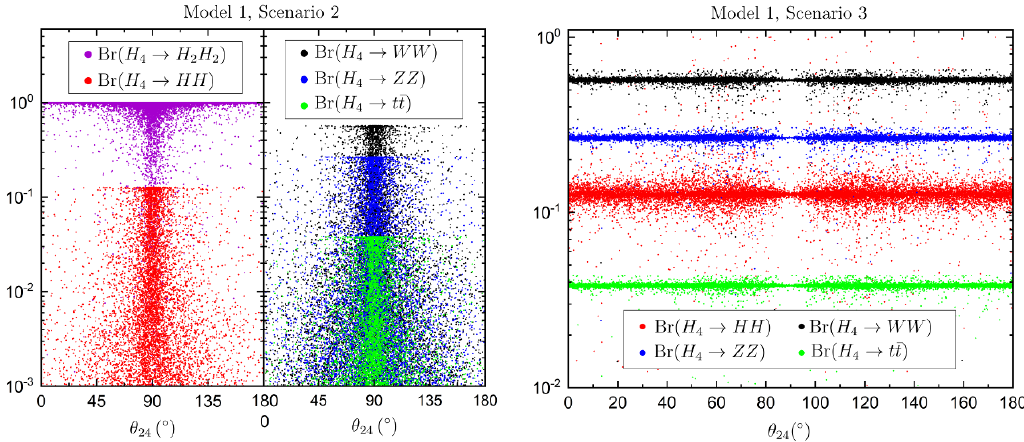
Figure 3 . Left: branching ratio for H 4 decays into di(cid:11)erent (cid:12)nal states in scenario 2 of model 1, resulting from a scan of allowed points in parameter space. Right: the same as in the left panel but for scenario 3 of model